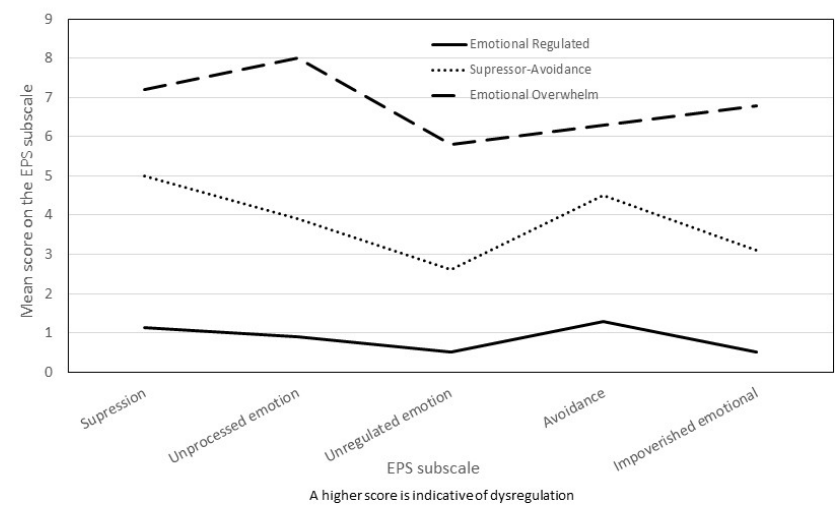
Figure 1. Profiles of emotional regulation in battered women. The results of the ANCOVA showed a significant global effect for the model (F(9.118) = 11.5, p < 0.001; η p2 = 0.49), a non-significant effect for type of victim, a significant effect according to the emotional regulation group (F(2.118) = 27.9, p < 0.001; η p2 0.34), a signifi- cant interaction between type of victim and emotional regulation group (F(4.114) = 10.5, p < 0.05; η p2 = 0.09), and a significant effect for the covariable childhood trauma (F(1.114) = 7.7, p < 0.01; η p2 = 0.064). Post-hoc comparisons in post-traumatic stress symptoms according to the emotional regulation group showed statistically significant dif- ferences between the three possible comparisons (all p < 0.001). Furthermore, the interaction pattern between type of victim and the emotional regulation group showed that for VSR and VSRDA women, the Emotional Regulated group differs from the other two emotional regulation groups in post-traumatic symptoms, and that in the VSRSA group of women, the Emotional Regulated and Avoidance/Non-Impoverished groups differ from the Emotional Overwhelm group in post-traumatic symptoms (see Figure 2). Table 2 shows the mean values for PTSD symptoms in each emotional regulation group and victim type.